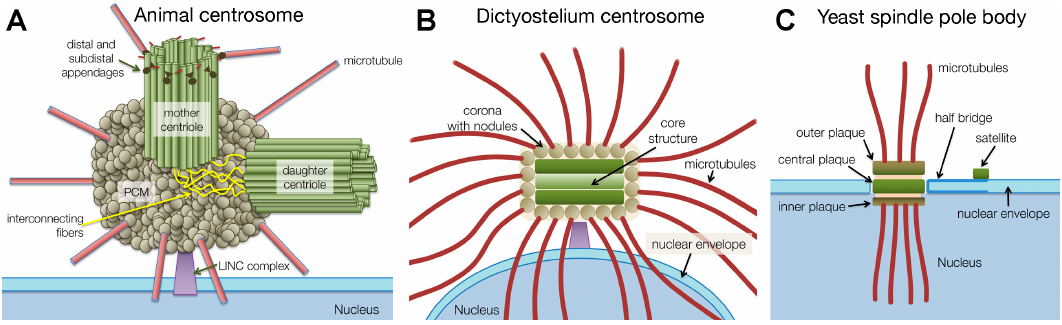
Figure 1. Schematic comparison of centrosomal structures in animals ( A ), Dictyostelium ( B ), and budding yeast ( C ). Functionally or topologically related structures are drawn in corresponding colors.